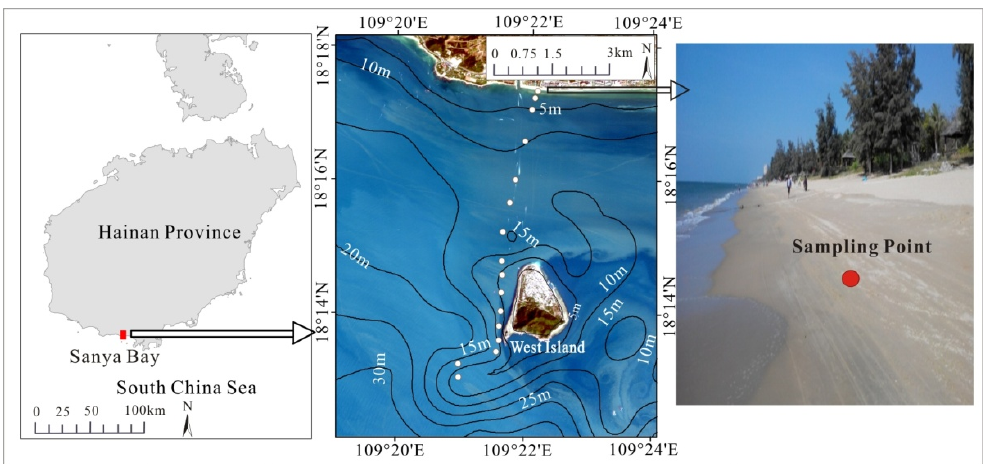
Figure 1. The geographic location of Sanya Bay, China. The white points in the SPOT6 image show the sampling locations of water. In the picture of the coast, the red point shows the sampling point of sand.